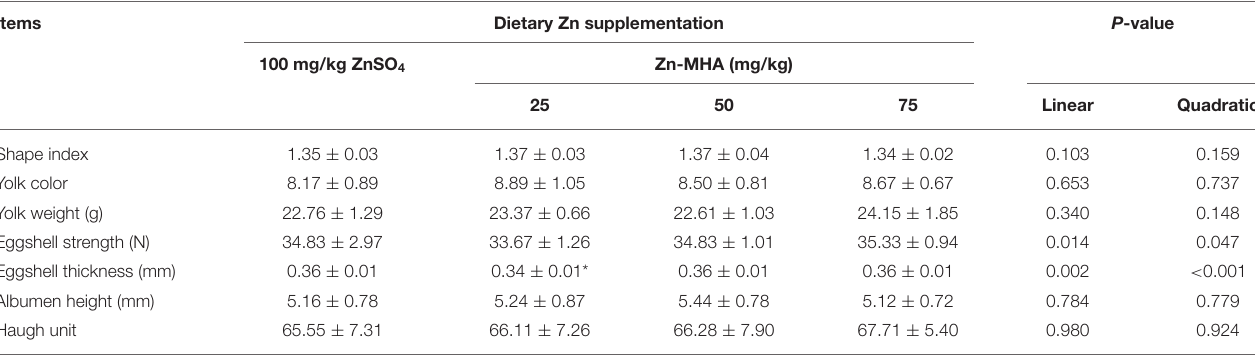
TABLE 4 | Effects of dietary Zn-MHA supplementation on egg quality of broiler breeders a .